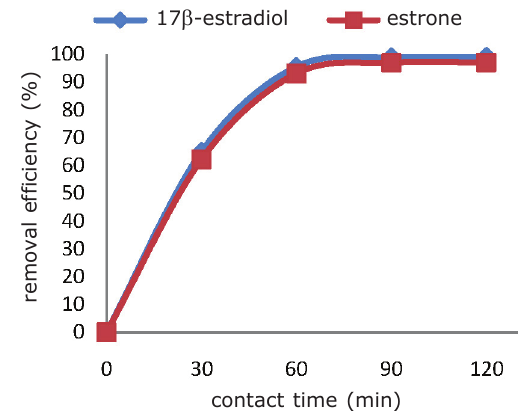
Fig. 6 – Effect of contact time on the removal efficiency of E2 and E1 (adsorbent dosage of 1.5 g L –1 , pH of 4, and 10 ng L –1 concentration of E2 and E1)